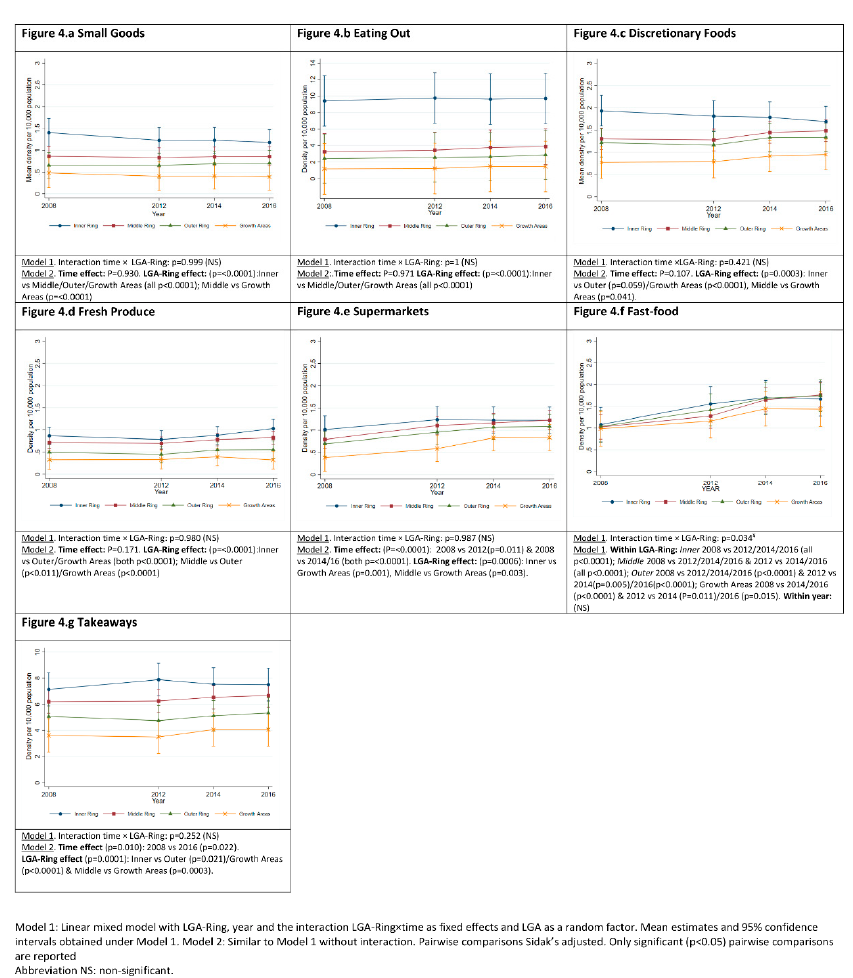
Figure 4. Food retail outlets grouped by type: density per 10,000 population over the period 2008-2016 and across local government areas grouped by distance from Greater Melbourne Central Business District.